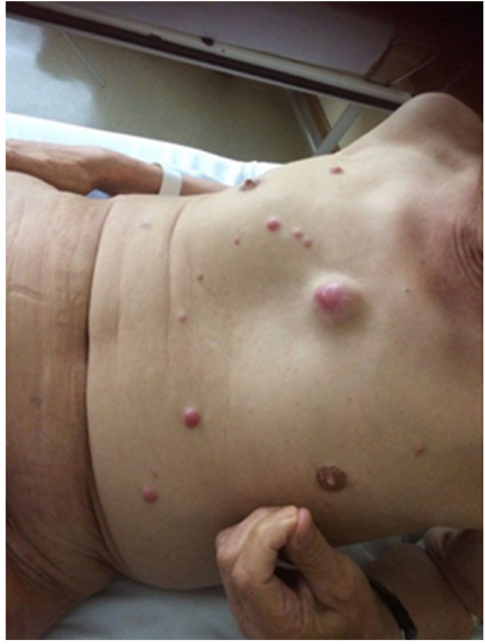
Figure 10. MCC spreading to the skin of the chest and abdomen (stage